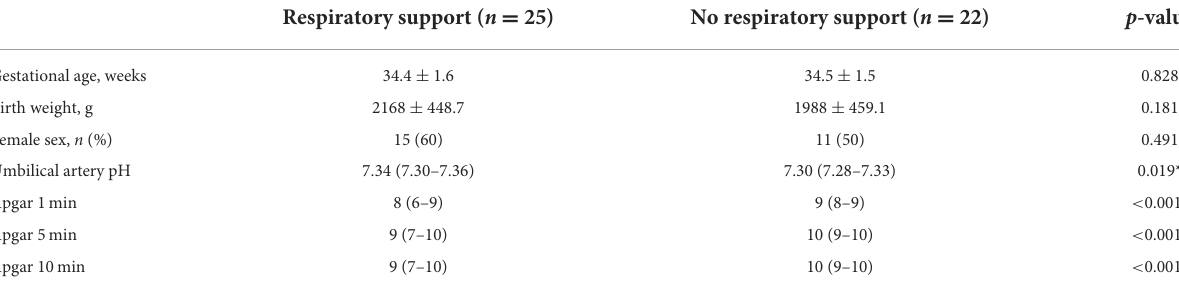
FIGURE1 Inclusion and exclusion of eligible neonates.